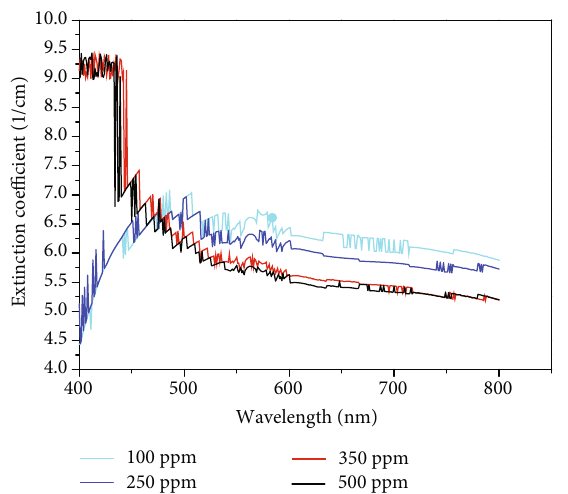
Figure 10: Extinction coe ffi cient of Therminol 55-TiO